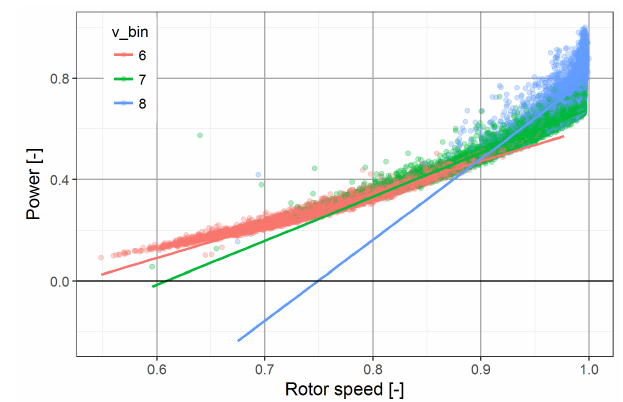
Figure 12. Power as a function of rotor speed with linear regression lines per wind speed